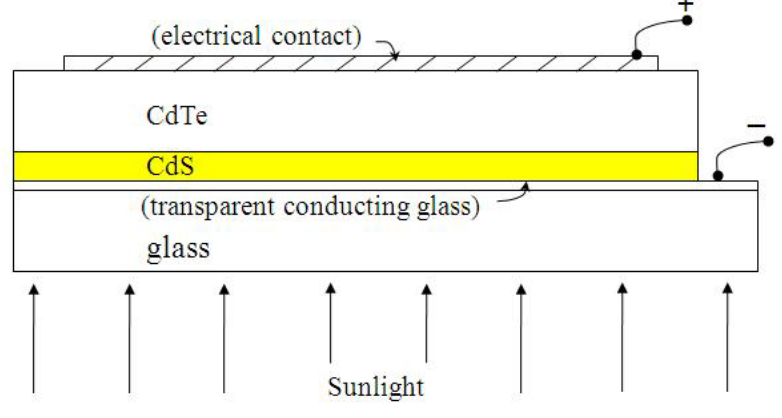
Figure 13. Schematic diagram of the CdS/CdTe thin film solar cell showing the basic layers required for a complete